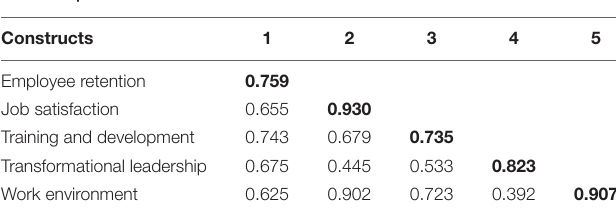
TABLE 2 | Fornell–Larcker